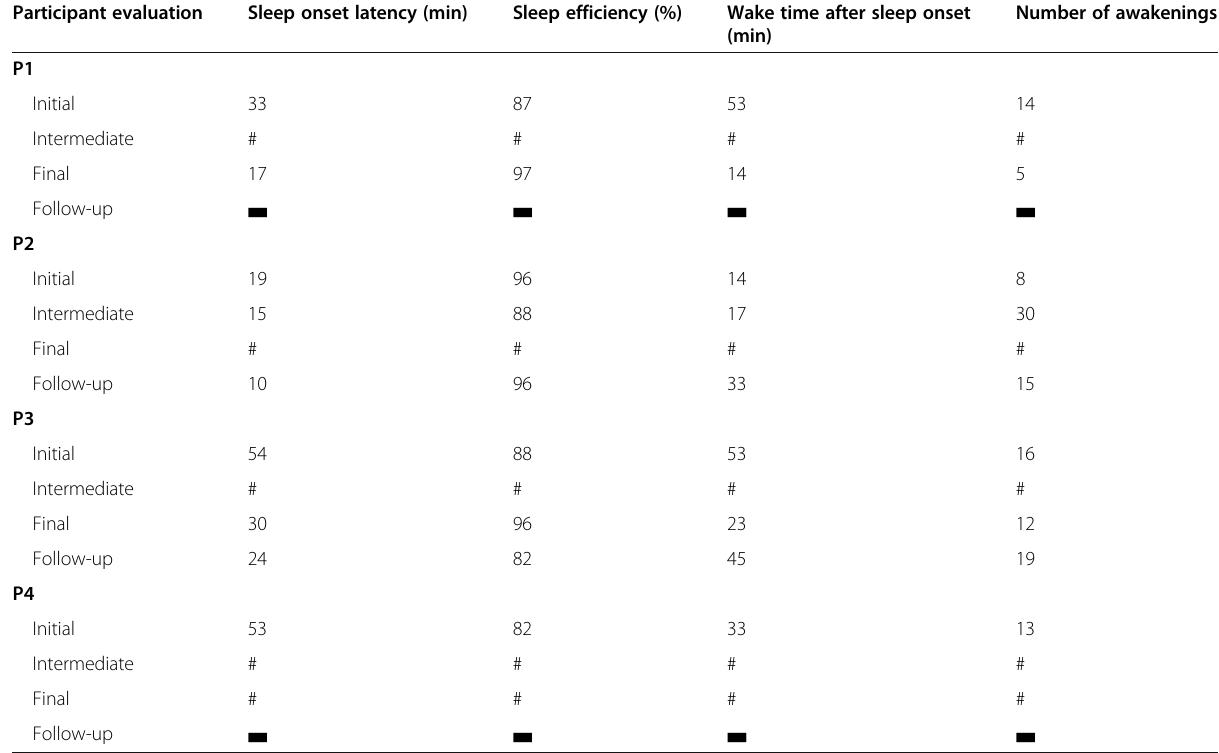
Table 2 Averages of sleep patterns recorded by actigraphy over a week Participant